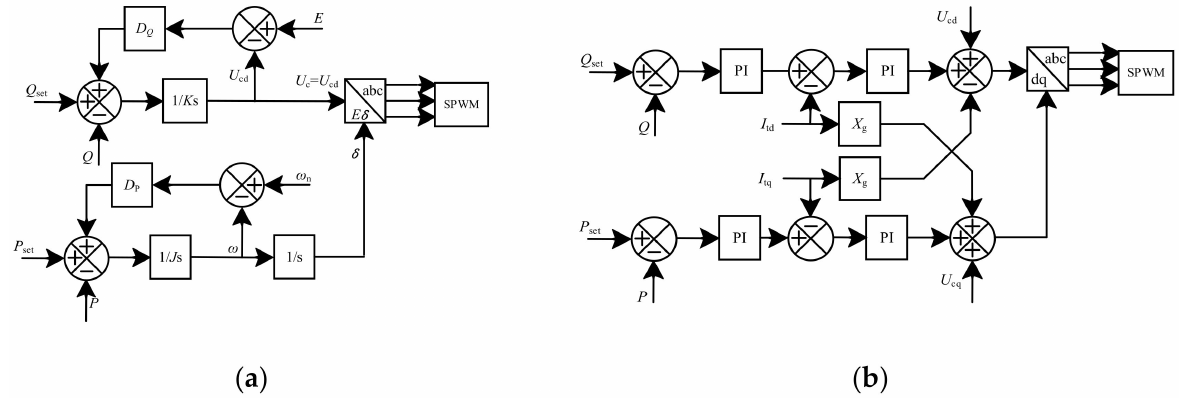
Figure 5. ( a ) Block diagram of a GFM converter; ( b ) block diagram of a GFL